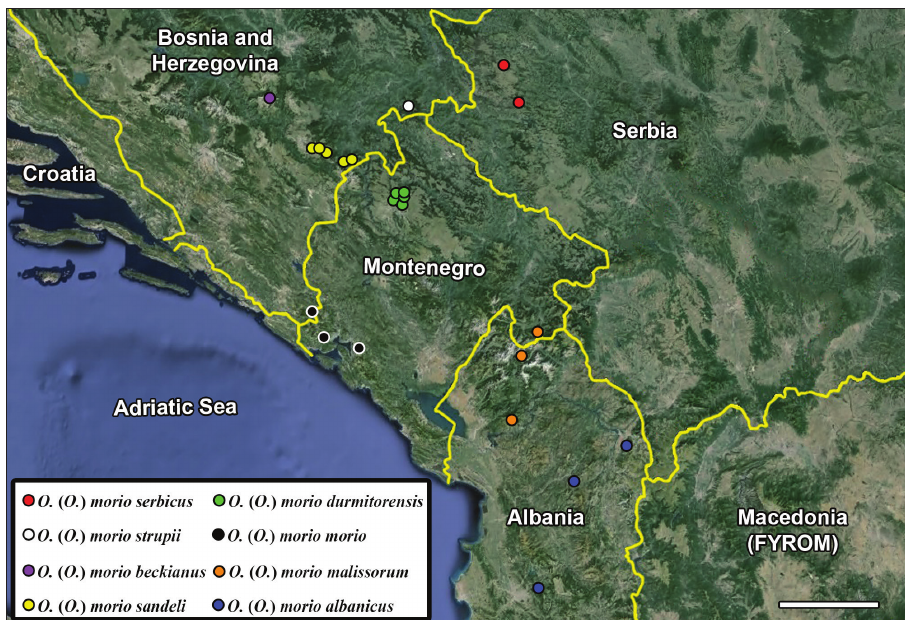
3 Subspecies of somewhat smaller size (R 16–18 mm), with less elongate elytra (length/width ratio: M around 1.66) (central Bosnia and Herzegovina) ........ ............................................... O. ( O. ) morio beckianus Ganglbauer, 1888 – Subspecies of somewhat larger size (M more than 18 mm), with more elon- gate elytra (the length/width ratio: M > 1.66) ............................................. 4 4 Antennae longer, hind pronotal angles more rounded, maximum width of pronotum between its fore fourth and third, elytra somewhat less elongate (length/width ratio: M 1.73) and wider, maximum width of elytra around the middle, shoulders rounded. Median lobe of aedeagus somewhat widened sub-apically in dorsal view, while curved and strongly widened sub-apically in lateral view, with a straight long acute triangular apex, basal bulb wide and short, male abdominal sternite IX (urite) less elongate, apex of the gonocox- ites IX rounded, somewhat larger body size (M 18.49 mm) (eastern Bosnia and Herzegovina) ............................................ O. ( O. ) morio sandeli ssp. n. – Antennae shorter, hind pronotal angles less rounded, maximum width of pronotum in front of the fore third, elytra more elongate (length/width ratio: M 1.79) and narrower, maximum width of elytra slightly below the middle, shoulders obtusely rounded. Median lobe of aedeagus strongly widened sub- apically in dorsal view, while arcuate, moderately widened and with a shallow concavity in the sub-apical part in lateral view, with a straight short rounded triangular apex, basal bulb narrow and elongated, male abdominal sternite